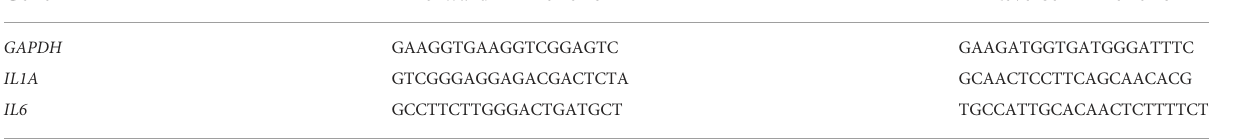
TABLE 1 Primer sequences used in this